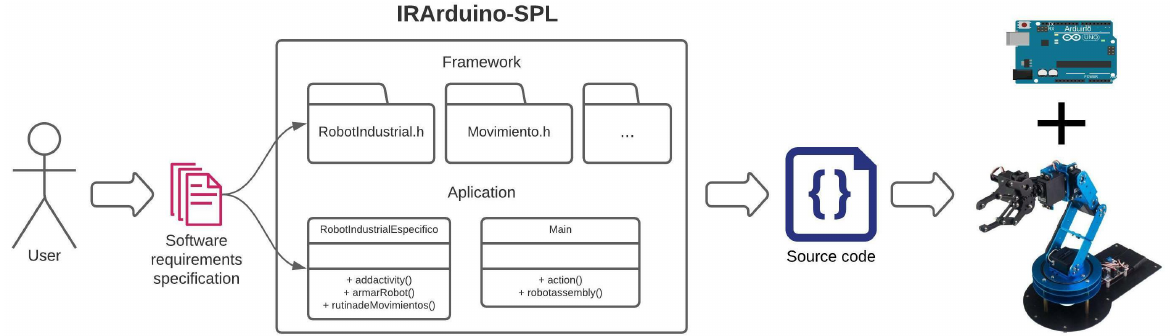
Figure 5. Generic IRArduino-SPL use case diagram for production of a product in the